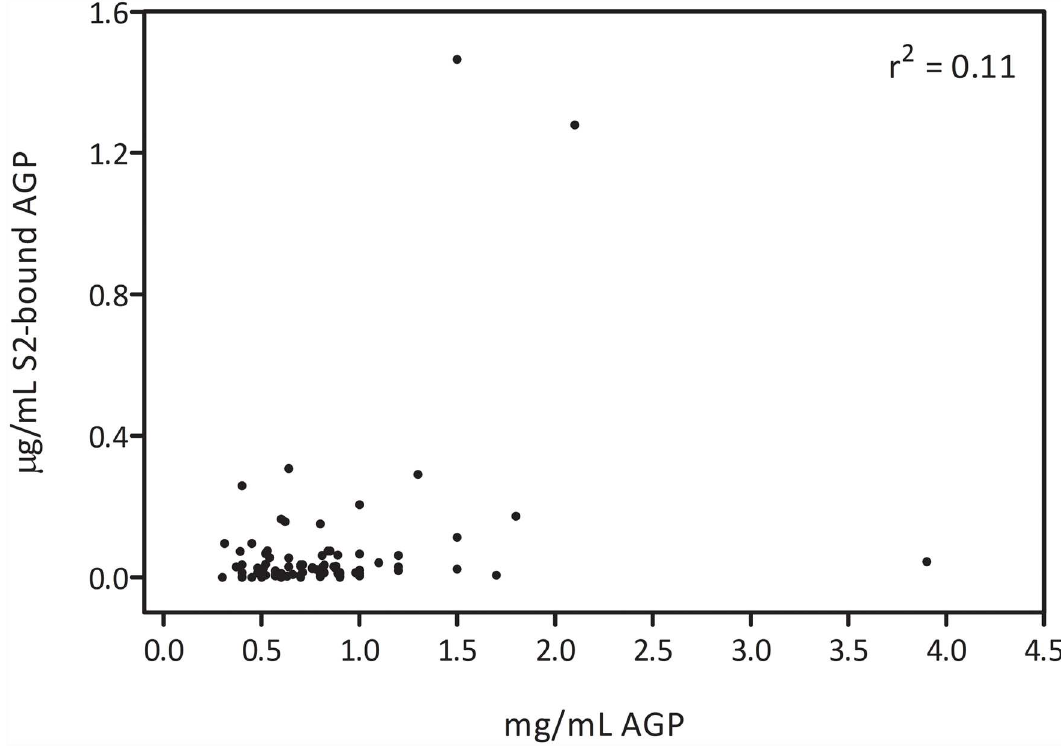
Fig 5. Correlation plot of levels of AGP and S2-bound AGP. The r square value is 0.11.